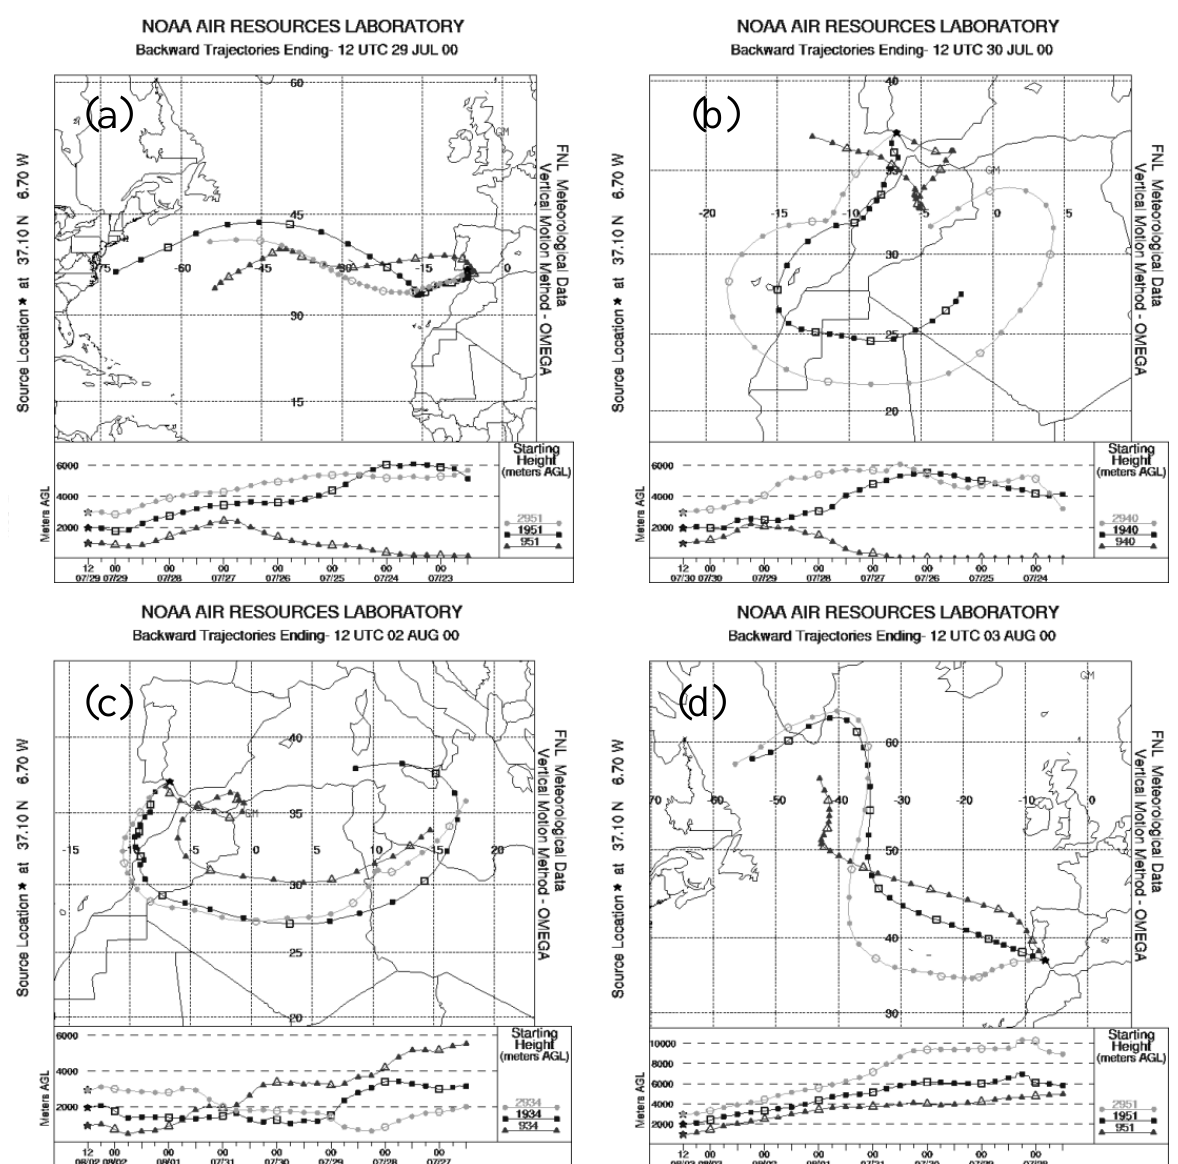
Fig. 7. The three levels of back-trajectories at 12:00 UTC at El Arenosillo on 29 and 30 July and 2 and 3 August, evaluated by the NOAA